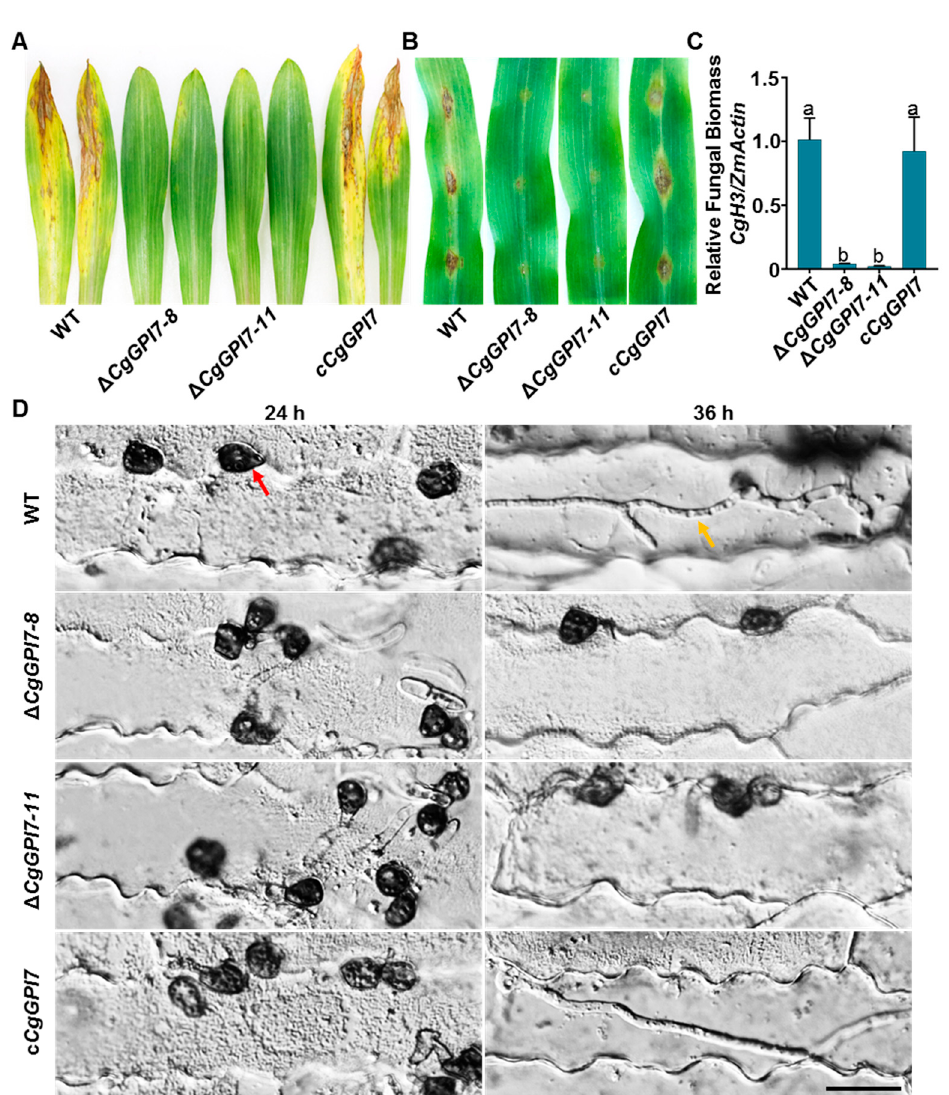
Figure 5. ∆ CgGPI7 mutants exhibit reduced pathogenicity. ( A ) Pathogenicity test by spray inoculation on live maize seedings. Pictures of inoculated leaves were taken at 5 dpi. ( B ) Pathogenicity test on detached maize seedling leaves. Pictures of inoculated leaves were taken at 5 dpi. ( C ) Relative fungal biomass of detached maize seedling leaves. Bar indicates the standard deviation of six technical duplications and the small letters indicate a significant difference ( p < 0.01). ( D ) Infection observation of wild type, Δ CgGPI7, and c CgGPI7 at 24 h and 36 h. The red and the orange arrow indicate appressorium and invasive hyphae, respectively. Bar = 25 μ m.